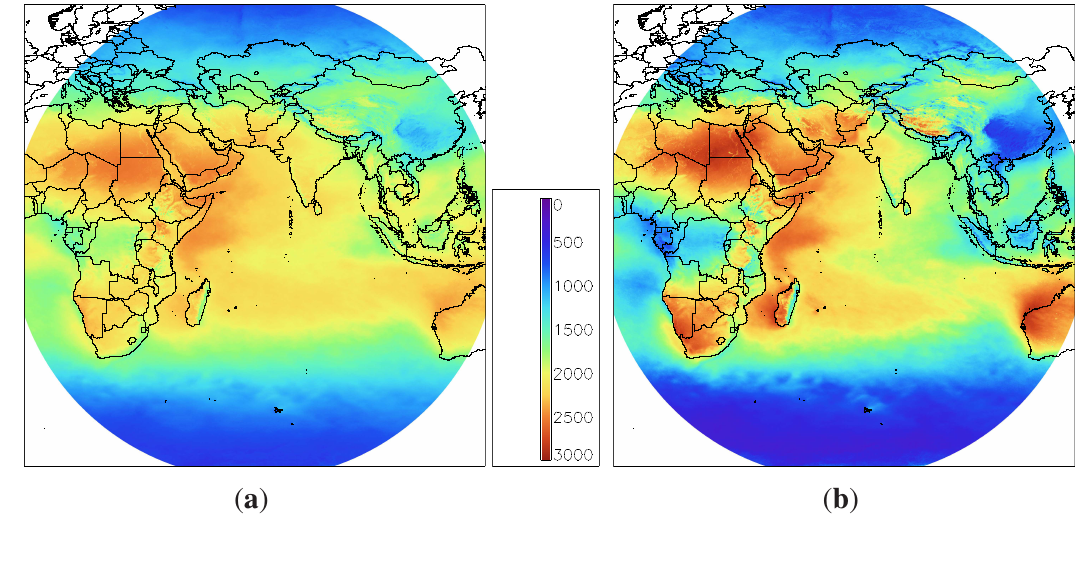
Figure 4. Yearly solar irradiation for the year 2002. ( a ) Global horizontal irradiation H ; ( b ) Direct normal irradiation, H . The values are in kWh m − 2 DNI